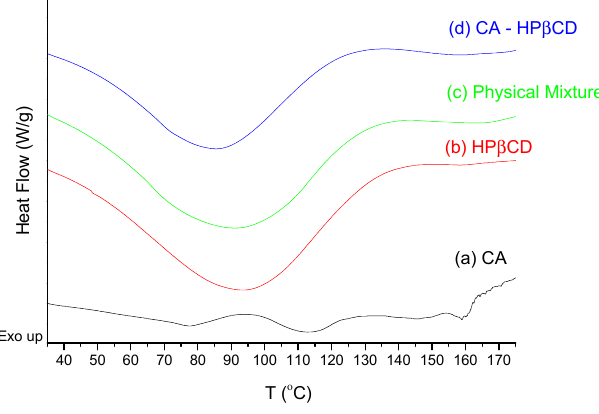
Figure 5. DSC thermograms of CA ( a ), HP β CD ( b ), their physical mixture ( c ), and system ( d ).